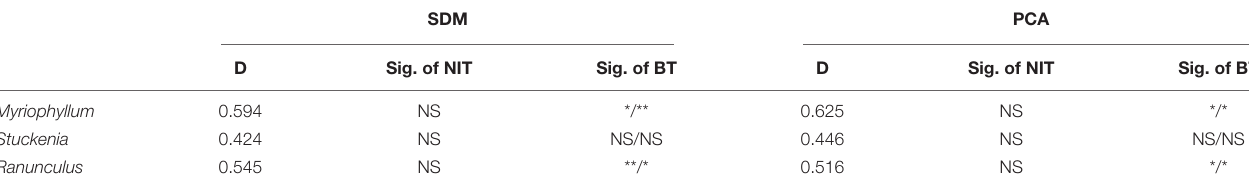
TABLE 3 | Niche overlap index and significance in tests of niche equivalency and backgrounds for related species pairs.